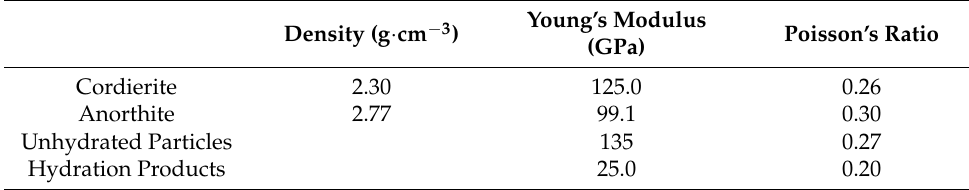
Table 1. Material parameters of different